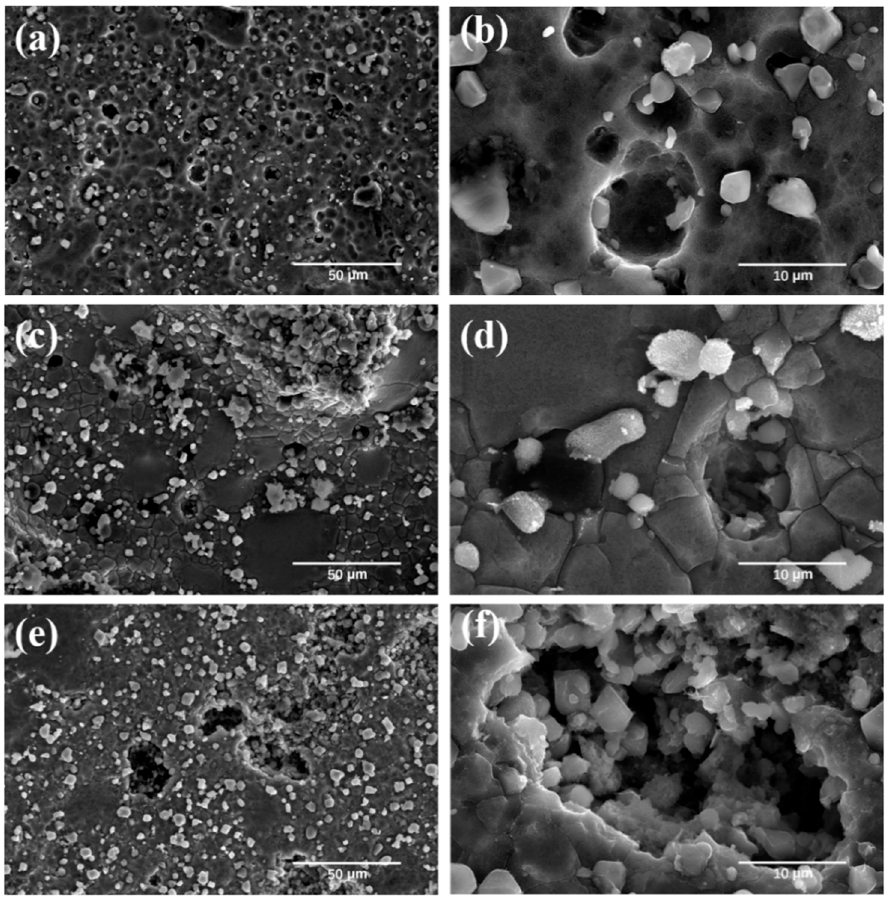
Figure 7. SEM images of the corrosion surfaces of Al-7%Si-0.3%Mg-0.3%Cr-1.5%Cu alloy aged at 175 °C for ( a , b ) 1 h, ( c , d ) 6 h, ( e , f ) 12 h after immersion for 30-days.